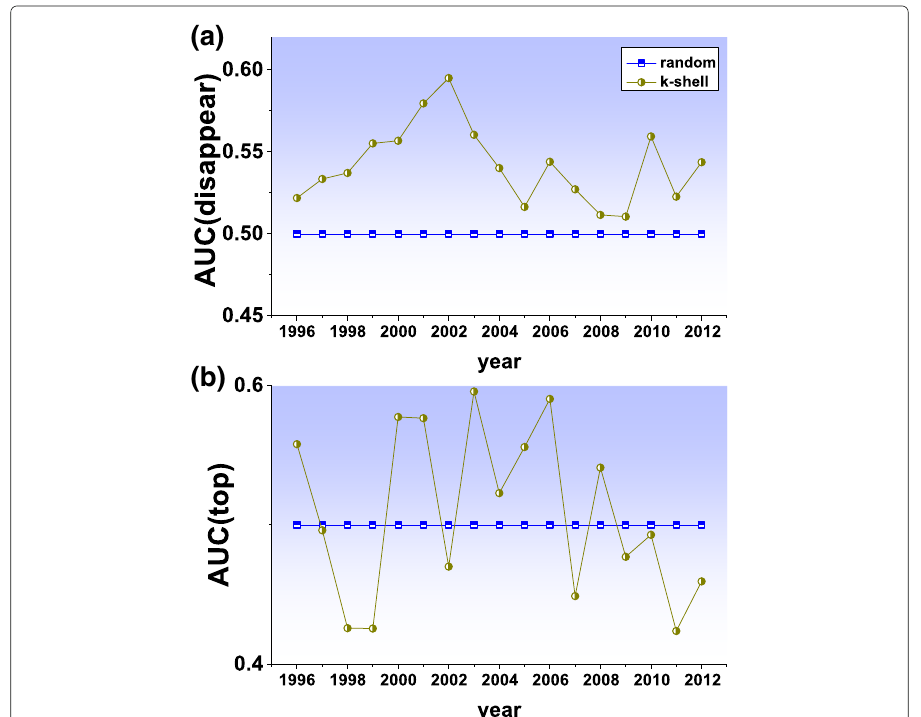
Fig. 7 The area under the ROC curve for ( a ) disappeared firms and ( b ) top return firms using forecasts from the K -shell methods